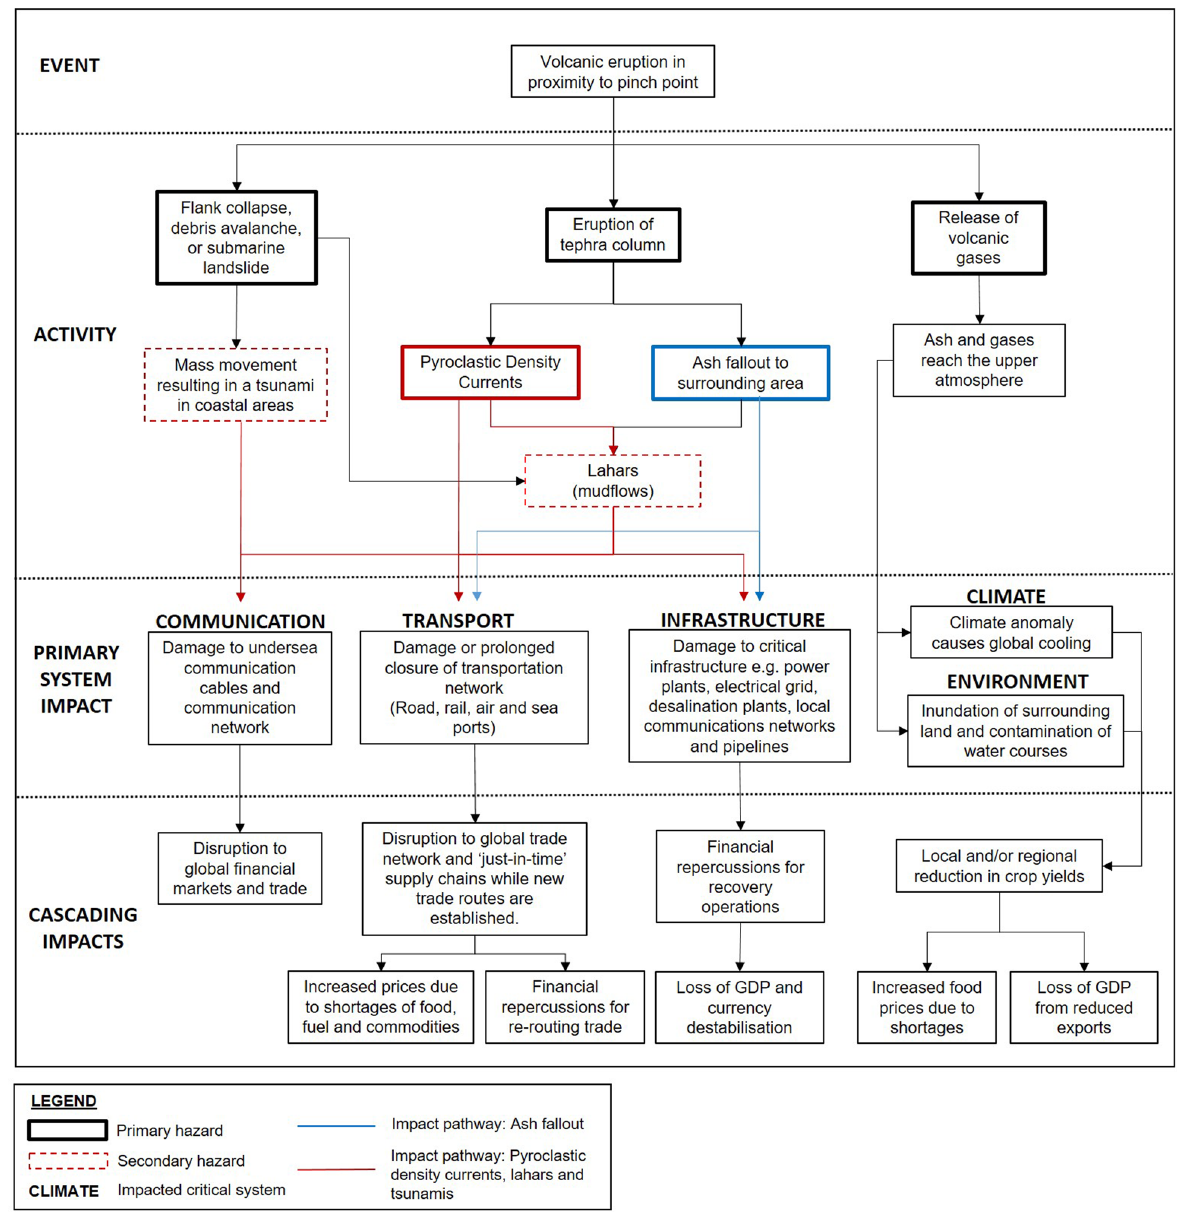
Fig. 1 Cascading system failures from lower magnitude volcanic eruptions. Event tree of lower-magnitude (Volcanic Explosivity Index 3 – 6) volcanic eruptions in proximity to global critical systems. The event tree demonstrates the propagation of cascading failures of related and interlinked critical systems, due to various eruptive hazards, such as the eruption of tephra column, ash fallout, and pyroclastic density currents, as discussed in this Comment. The fi gure identi fi es the pathways from systems that are directly vulnerable to such activities to secondary and tertiary knock-on rami fi cations for interlinked systems. The blue boxes and arrows depict the impact pathway linked to volcanic ash fallout, whilst the red boxes and arrows show the impact pathway for pyroclastic density currents (PDCs), lahars, and tsunamis. Thick black outlined boxes present primary hazards whilst dashed outline boxes identify secondary